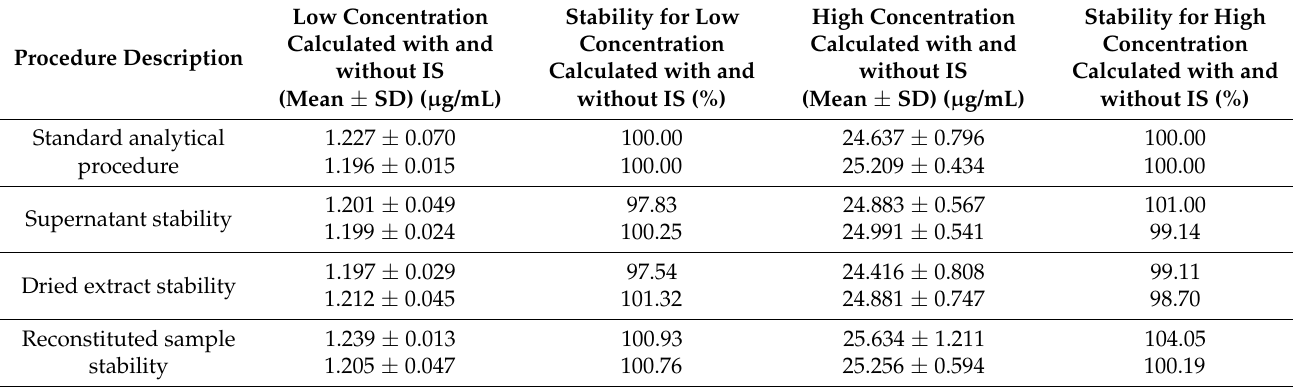
Table 4. Short-term stability ( n =